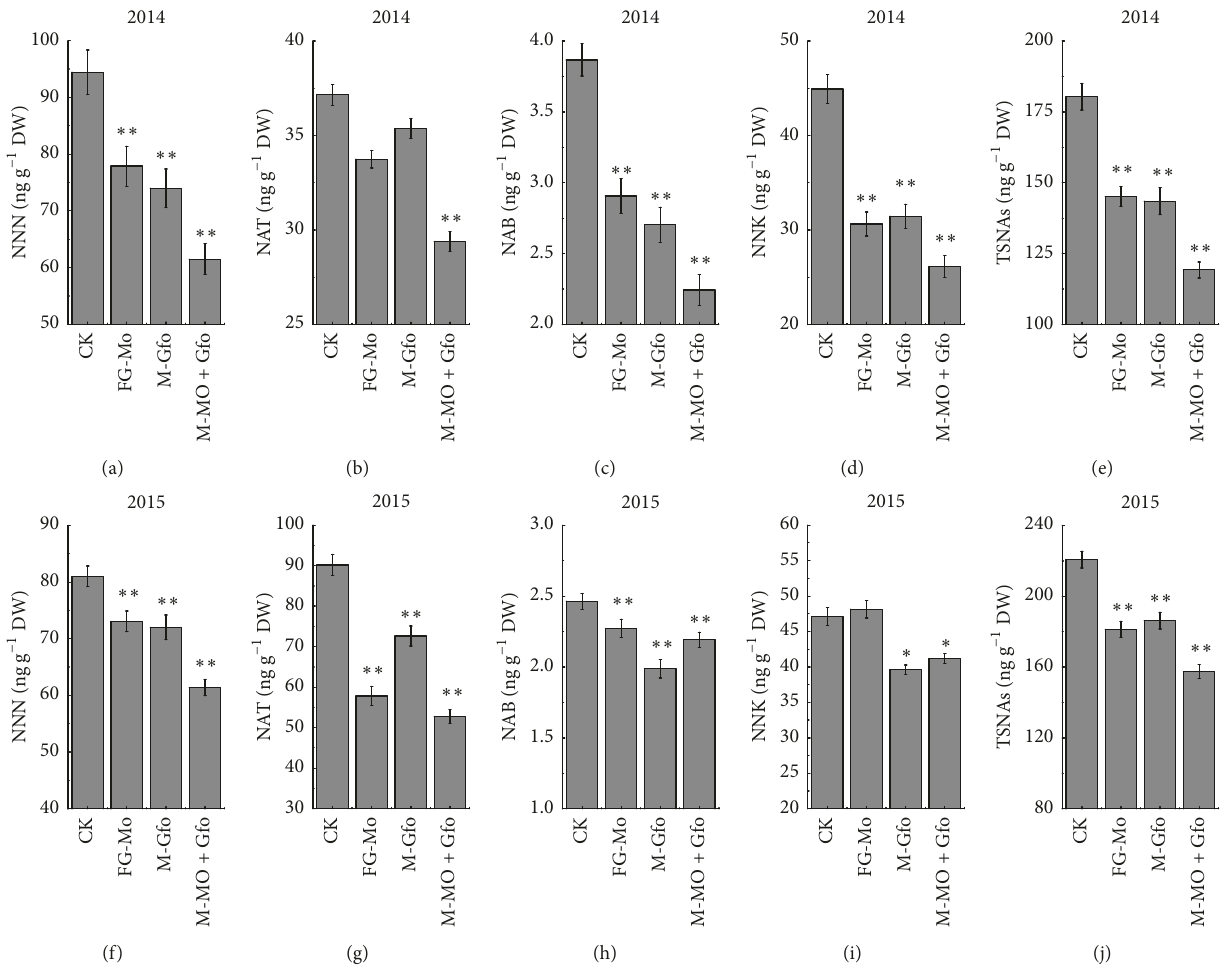
Figure 5: Effects of chemical regulation on NNN, NAB, NAT, NNK, and total TSNA concentration in flue-cured tobacco. Error bars indicate standard error ( 𝑛 = 3 ). Symbols ∗∗ and ∗ indicate significant difference at 0.01 or 0.05,